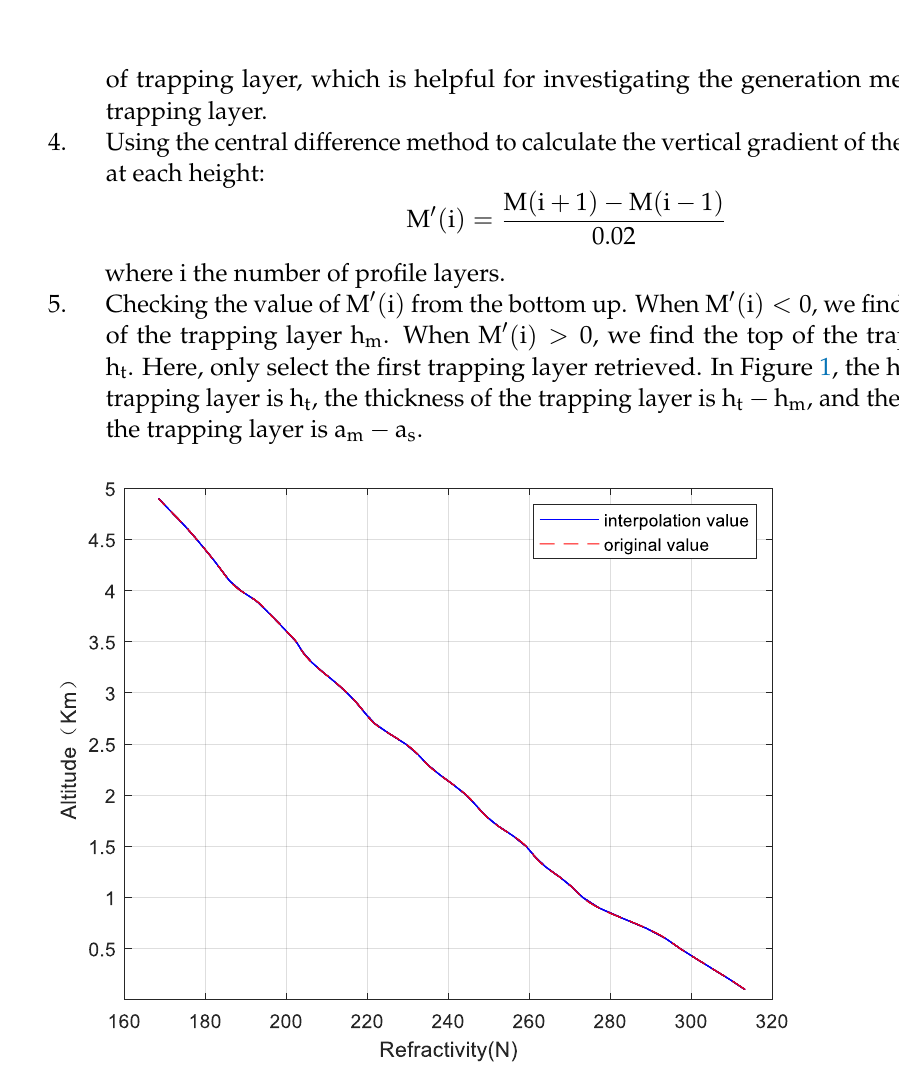
Figure 2. A comparative example of refractivity data before and after cubic spline interpolation.